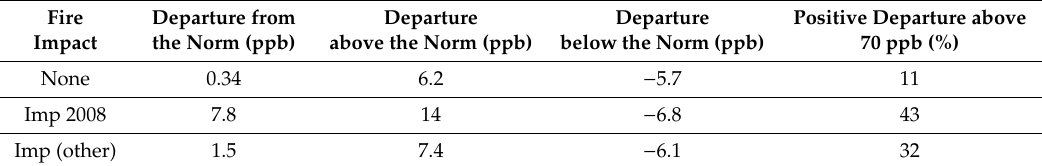
Table 1. Median ozone departures from normal and percentage of positive departures above 70 ppb for various levels of fire impact (Imp) and year. Imp (other) category includes fire impacted cases for all years but 2008.